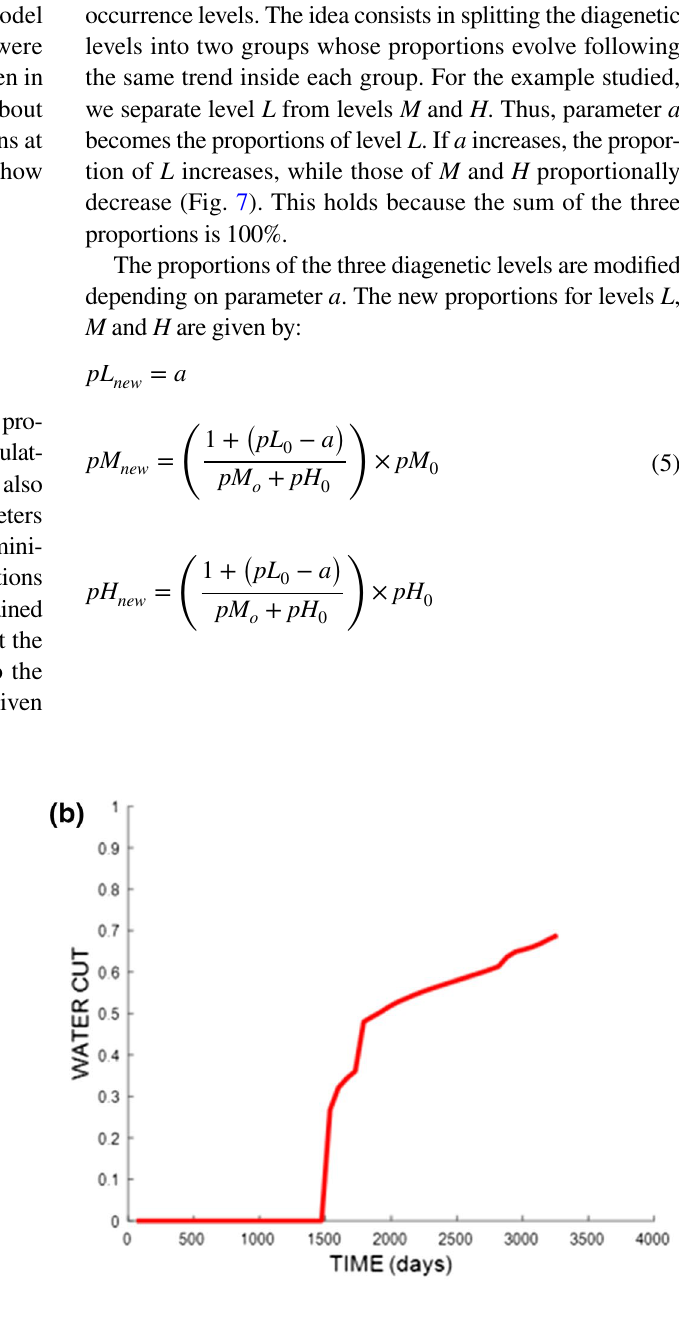
Fig. 6 a Water saturation map at breakthrough time. b Reference water